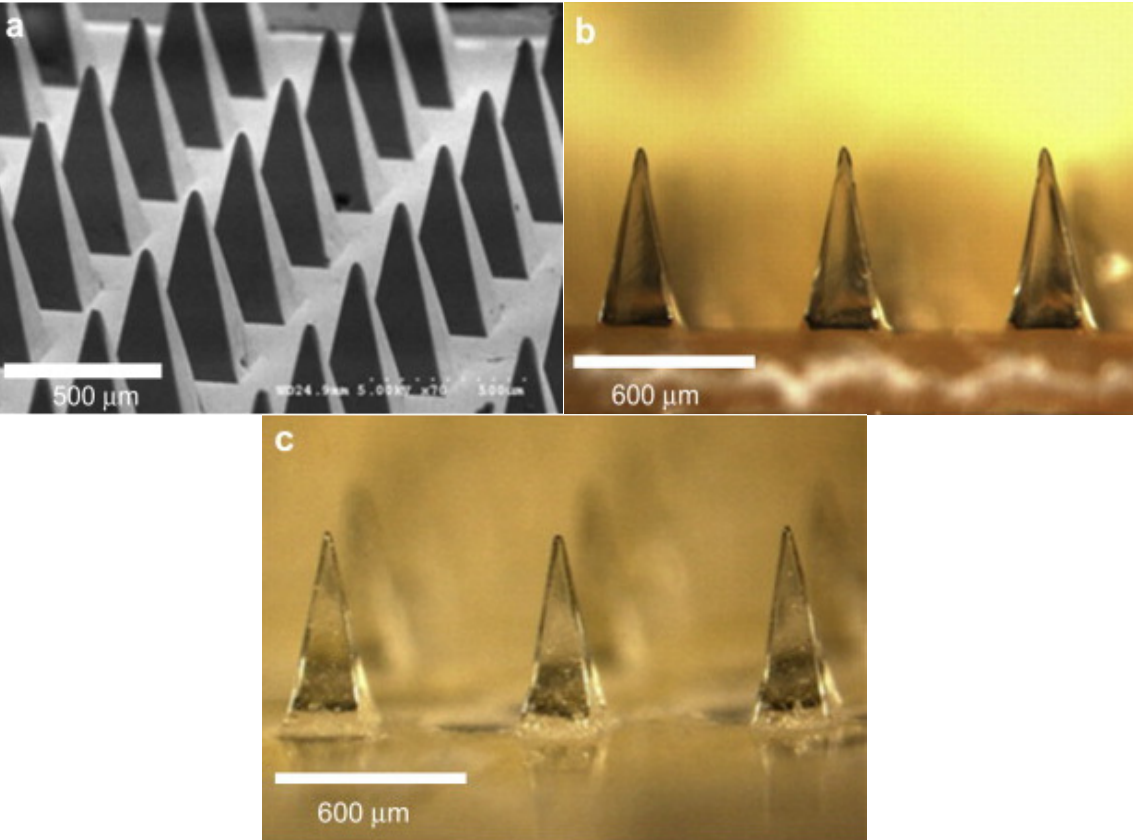
Figure 5. Dissolving microneedles for transdermal drug delivery. ( a ) Microneedle master-structure (600 μ m in height and 300 μ m wide at base) used to mold dissolving microneedles made of ( b ) carboxymethyl cellulose (CMC), and ( c ) amylopectin. The master-structure was imaged by scanning electron microscopy and the molded microneedles were imaged by brightfield microscopy [73] (reproduced with permission from